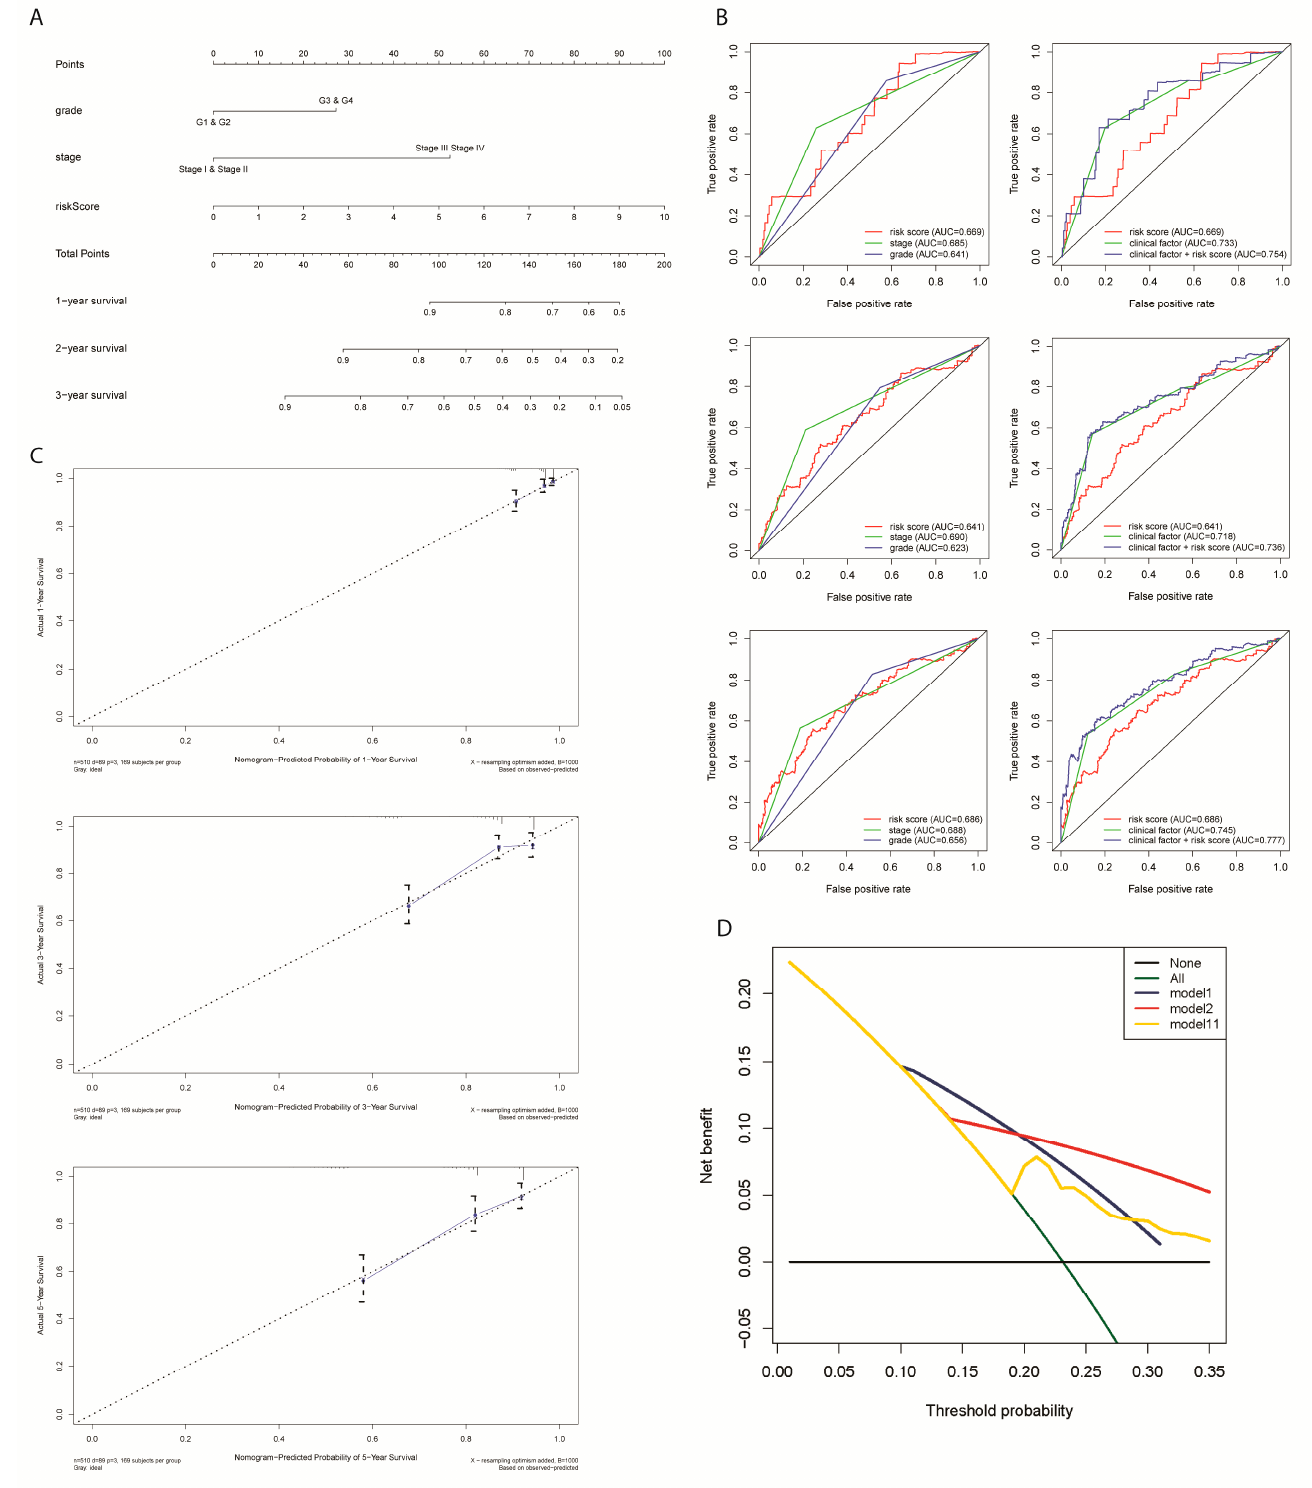
Figure 9. Predictive significance of signature verified in the nomogram model incorporating hypoxia-related gene signature and clinical characteristics. ( A ) Construction of a nomogram combining the four-gene signature and clinical features for the prediction of OS. ( B ) 1-,3-,5-year multi-ROC analysis for the final decision of the prognostic models. ( C ) Calibration plots displayed the actual and nomogram-predicted probability of one- (up), three- (middle), and five-year OS (down). ( D ) Decision curve analysis (DCA) curves of the nomogram for OS in HCC.